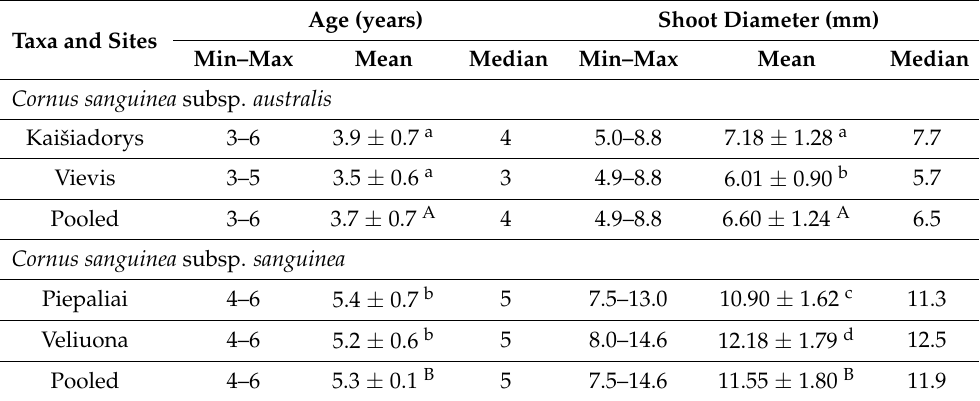
Table 2. Comparison of the age of the youngest fruiting shoots and the diameter of Cornus sanguinea subsp. australis and Cornus sanguinea subsp. sanguinea at the study sites. Different lowercase superscript letters indicate significant differences in the mean values between sites and different capital letters between subspecies relate to the results of the Mann–Whitney